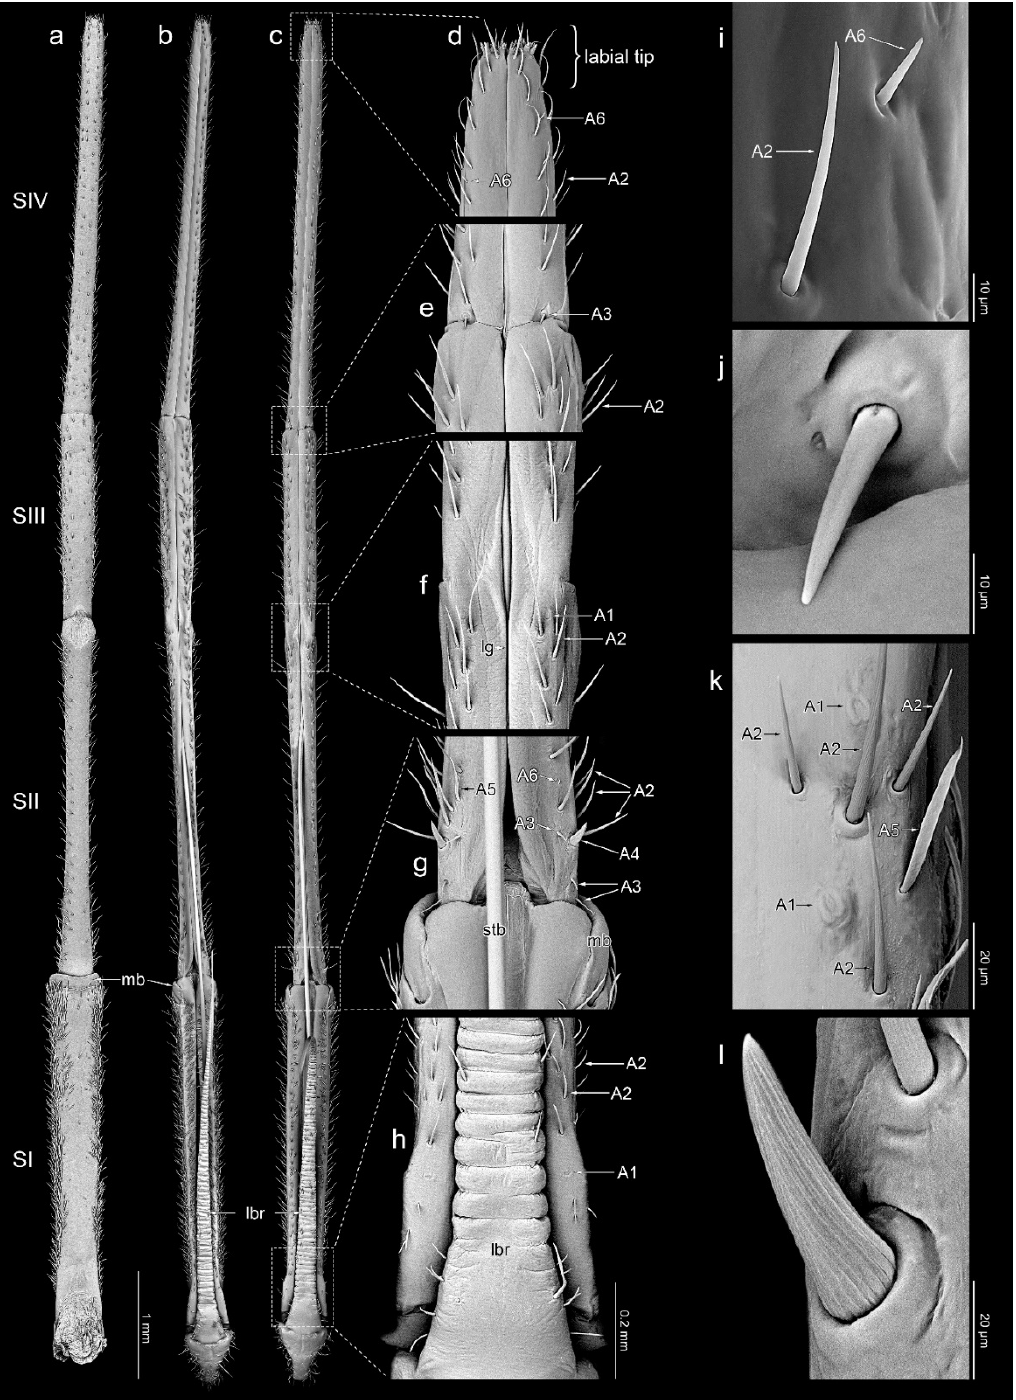
Figure 2. Detailed morphology of the labium; ventral view ( a ), dorsal view ( b – d ); detailed structure of selected parts of labium: apical part ( d ), connection of the segment III and IV ( e ), connection of the segment II and III ( f ), connection of the segment I and II ( g ), basal part of labium ( h ); particular sensilla in magnification: A2 and A6 ( i ), A3 ( j ), A1, A2, A5 ( k ), A4 ( l ). Leptoglossus zonatus ( a , b , k